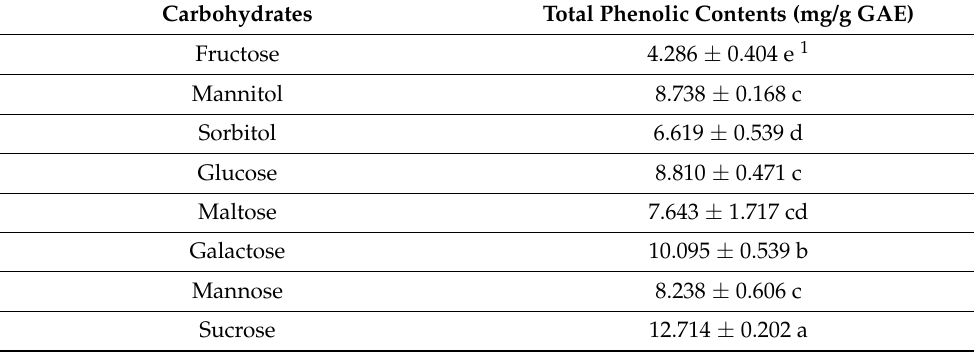
Table 3. Effects of different carbohydrates on the total phenolic contents in hairy root cultures of A. rugosa